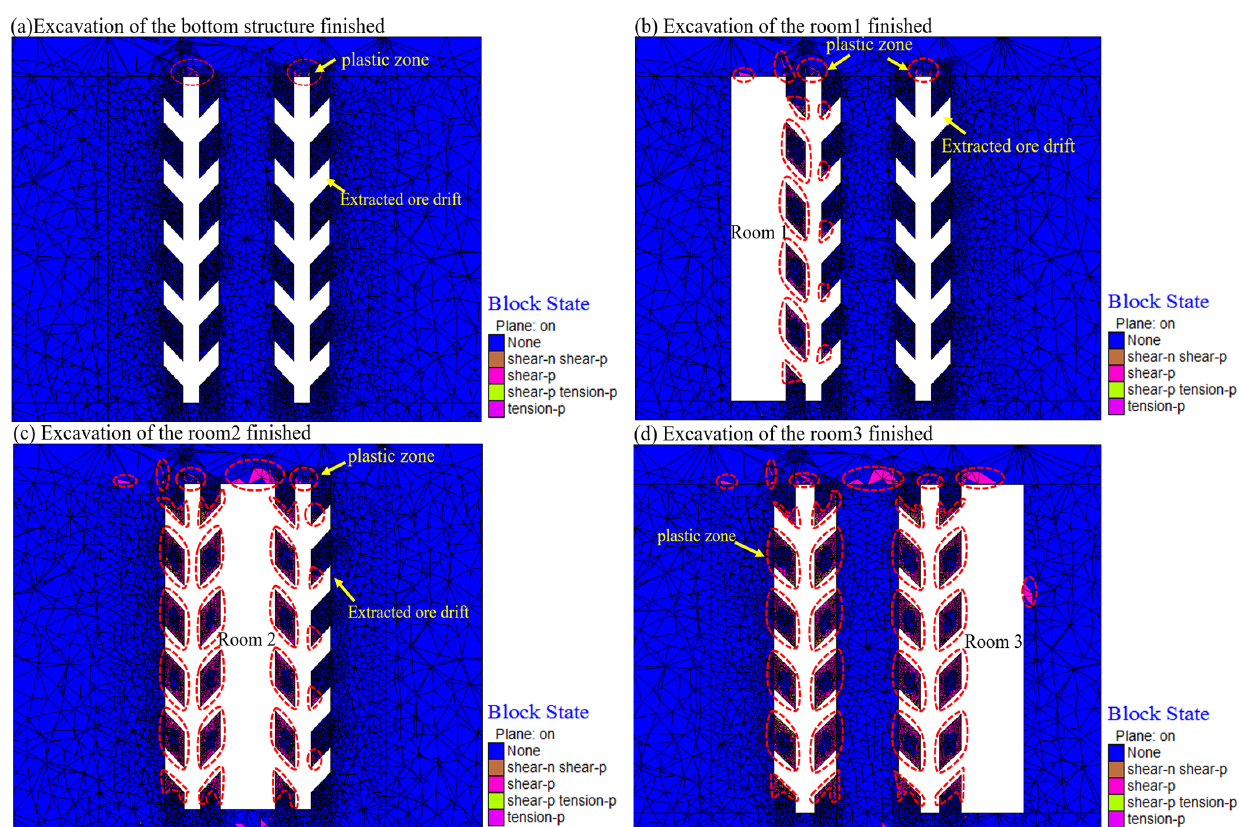
Figure 6. Distribution of plastic zone. ( a ) Excavation of the bottom structure finished ( b ) Excava- tion of the room 1 finished ( c ) Excavation of the room 2 finished ( d ) Excavation of the room 3 fin- ished.